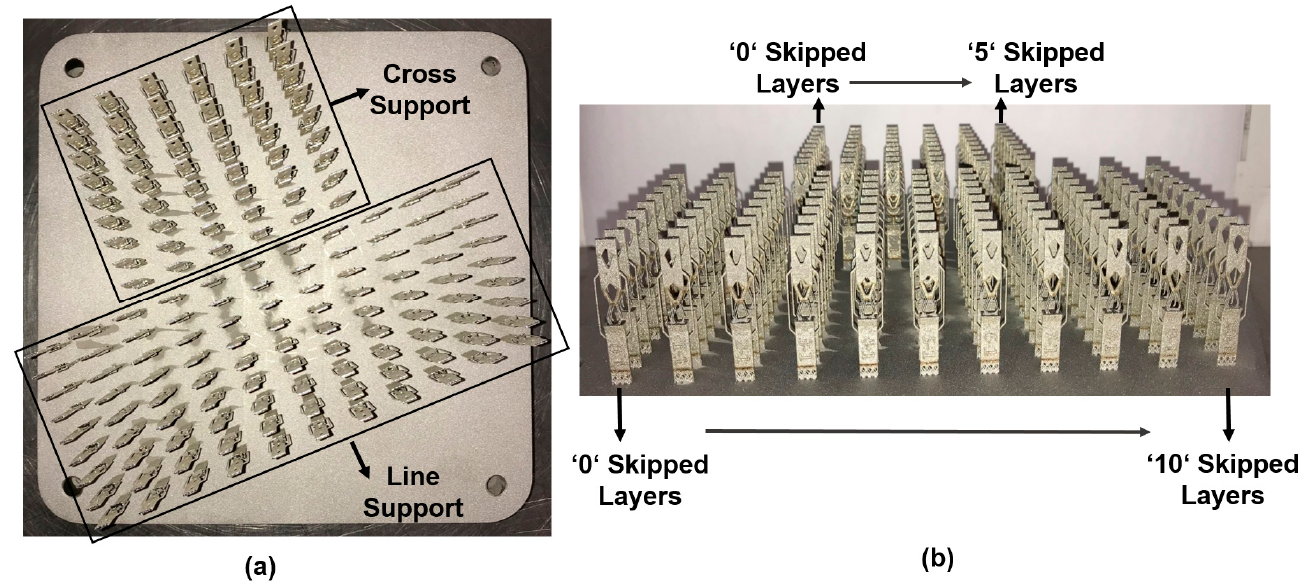
Figure 8. ( a ) Top and ( b ) front view of the specimens fabricated using line and cross supports. Type of support and the number of skipped layers are mentioned in ( a , b ), respectively.